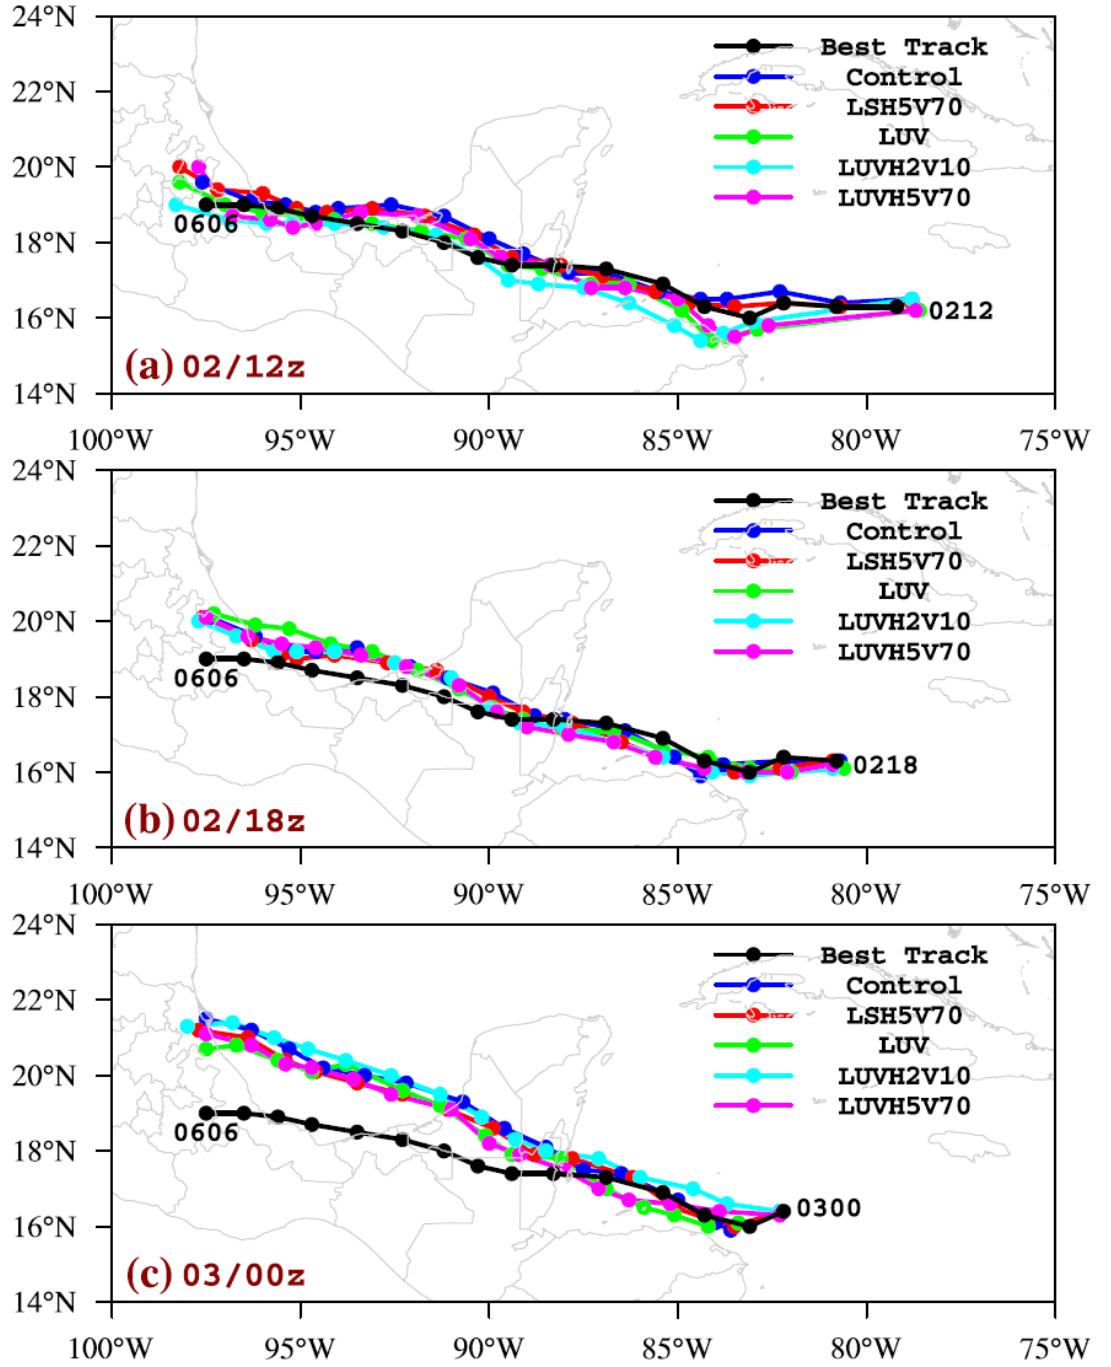
Figure 2. Comparison of forecast track for Hurricane Earl from the DWL wind speed and wind component assimilation experiments against Control and best track at ( a ) 12 UTC 2, ( b ) 18 UTC 2, and ( c ) 00 UTC 3 August 2016.